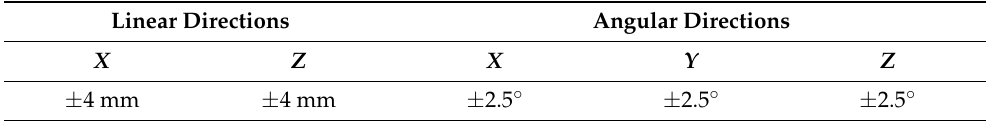
Table 2. Tolerance range of the passive alignment